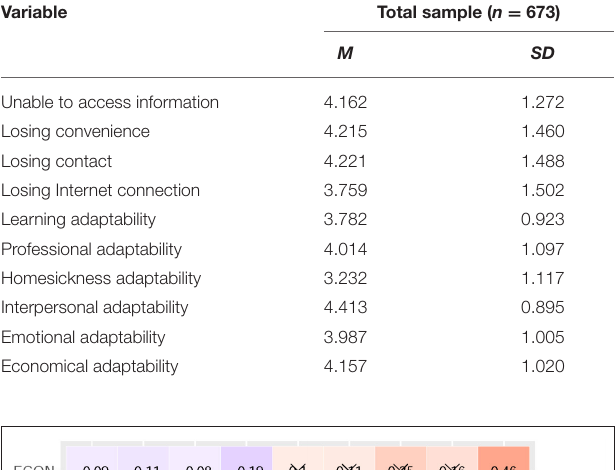
TABLE 1 | Descriptive statistics for the nomophobia and adaptability.